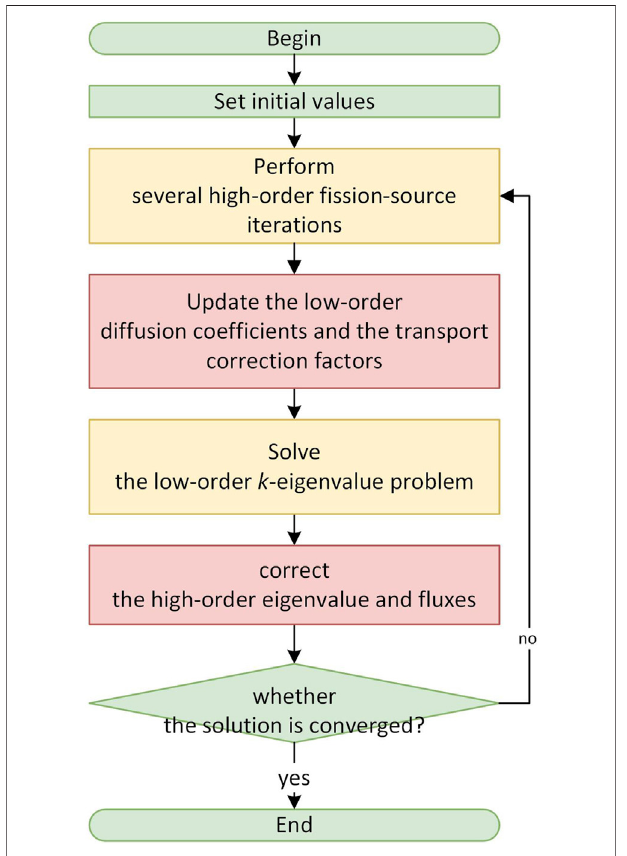
FIGURE 2 | Flowchart of the rCMFD acceleration